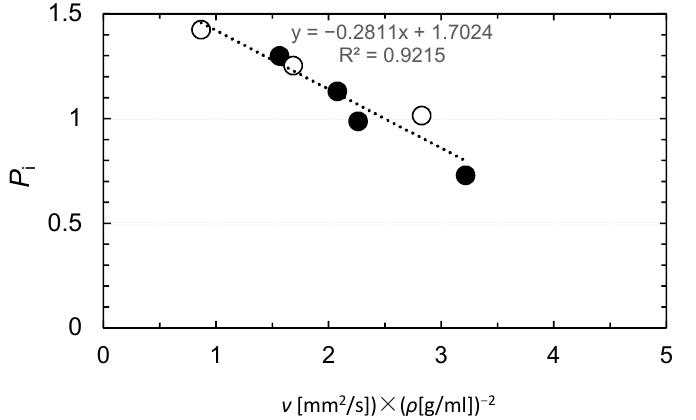
Figure 5. ( a ) Relationship between f and f’ for the aqueous phase; ● A1, ○ A2, and ▲ A3 in Table 1. ( b ) Relationship between f and f’ for the oil phase; ● O1, ○ O2, ▲ O3, and △ O4 in Table 1.